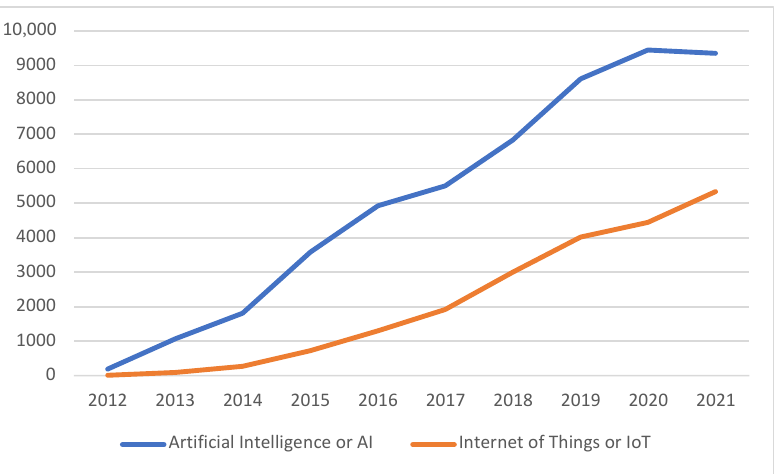
Figure 7. The number of research publications related to Big Data per year for AI and